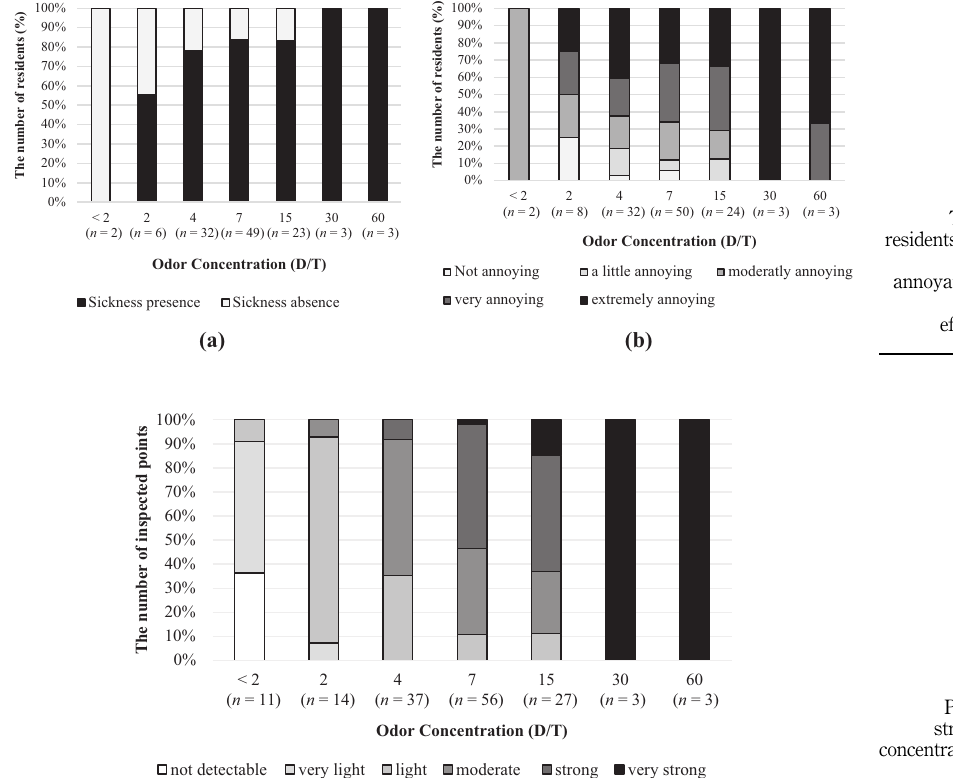
Figure 3. Perceived odor strength at each concentration ( n 5